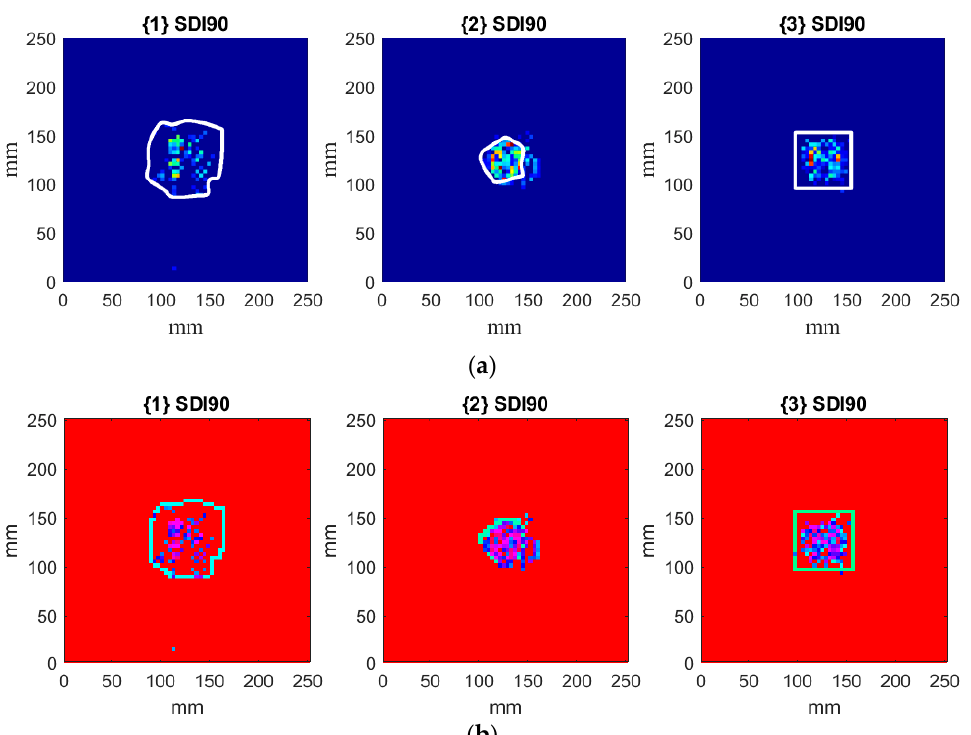
Figure 12. The quantification results for the considered damage scenarios with the ratios of areas of identified A id and true damage A tr .